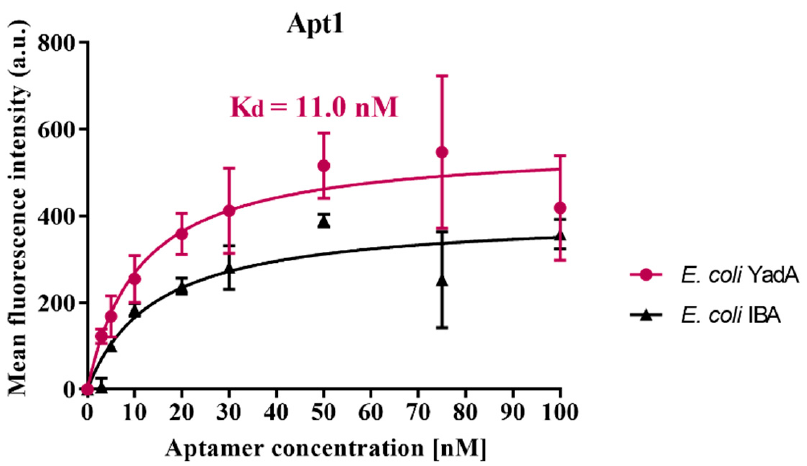
Figure 4. Determination of the equilibrium dissociation constant of candidate aptamer Apt1. The binding curves of aptamer Apt1 with E. coli YadA and E. coli IBA cells (control), respectively, is shown. The cells were incubated with increasing concentrations of FAM-labelled aptamers and assessed by fluorescence spectrophotometer. Equilibrium dissociation constant ( K d ) (nM) was calculated using GraphPad Prism 7, under the non-linear fit model, one-site non-competitive binding to fluorescent population ratio at given aptamer concentrations. a.u = arbitrary units.